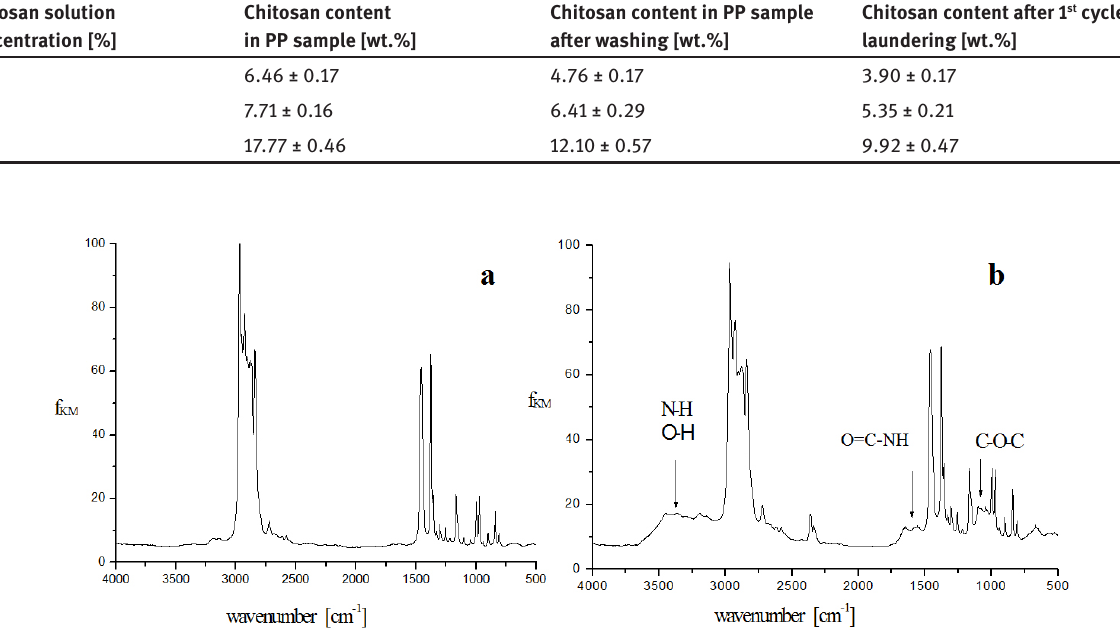
Figure 4: The DRIFT spectra of a) polypropylene nonwoven, b) polypropylene nonwoven with chitosan